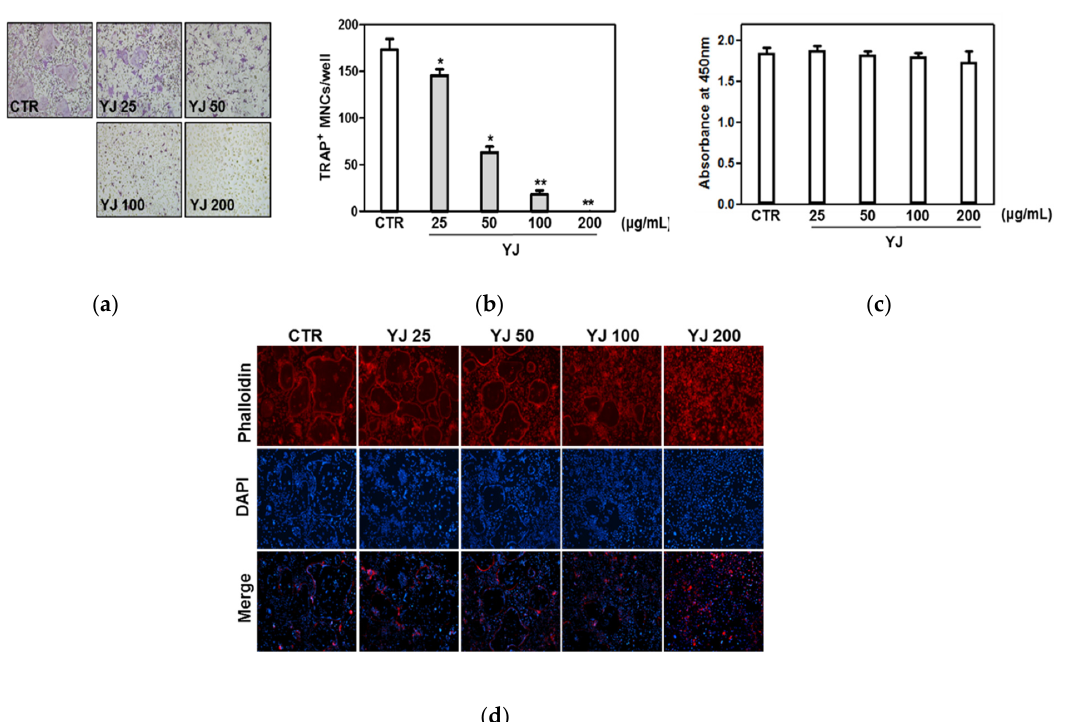
Figure 3. YJ suppressed RANKL-mediated TRAP-positive osteoclast formation. Bone marrow macrophages (BMMs) were cultured in differentiation medium containing M-CSF (30 ng/mL) and RANKL (100 ng/mL) for 4 days with vehicle or YJ ( n = 4). ( a ) BMMs were fixed, permeabilized, and stained with TRAP solution. Images were captured under a light microscope (100× magnification). ( b ) TRAP-positive MNCs were counted on day 4. TRAP-positive MNCs with >3 nuclei were counted as osteoclasts. ( c ) After YJ treatment for 4 days, cell viability was measured by XTT assay. ( d ) Cells were fixed with 3.7% formalin, permeabilized with 0.1% Triton X-100, and stained with phalloidin (red) and DAPI (blue). Images were obtained by fluorescence microscope (100× magnification). The data presented are the mean ± SD of four independent experiments. * p < 0.05, ** p < 0.01 vs. the control group.